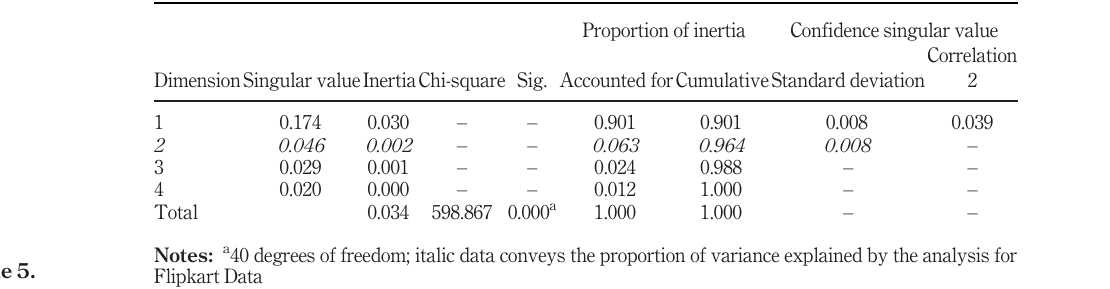
Table 4. Correspondence table